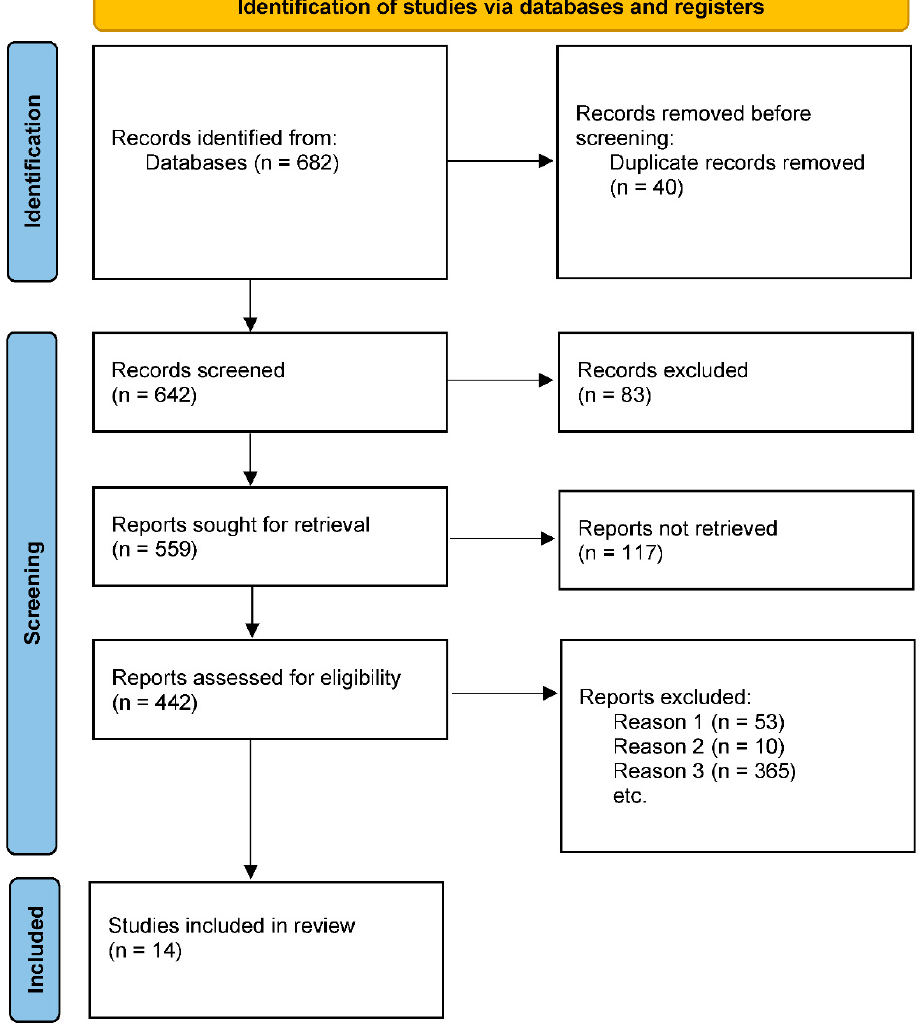
Figure 1. Flow chart of literature screening.